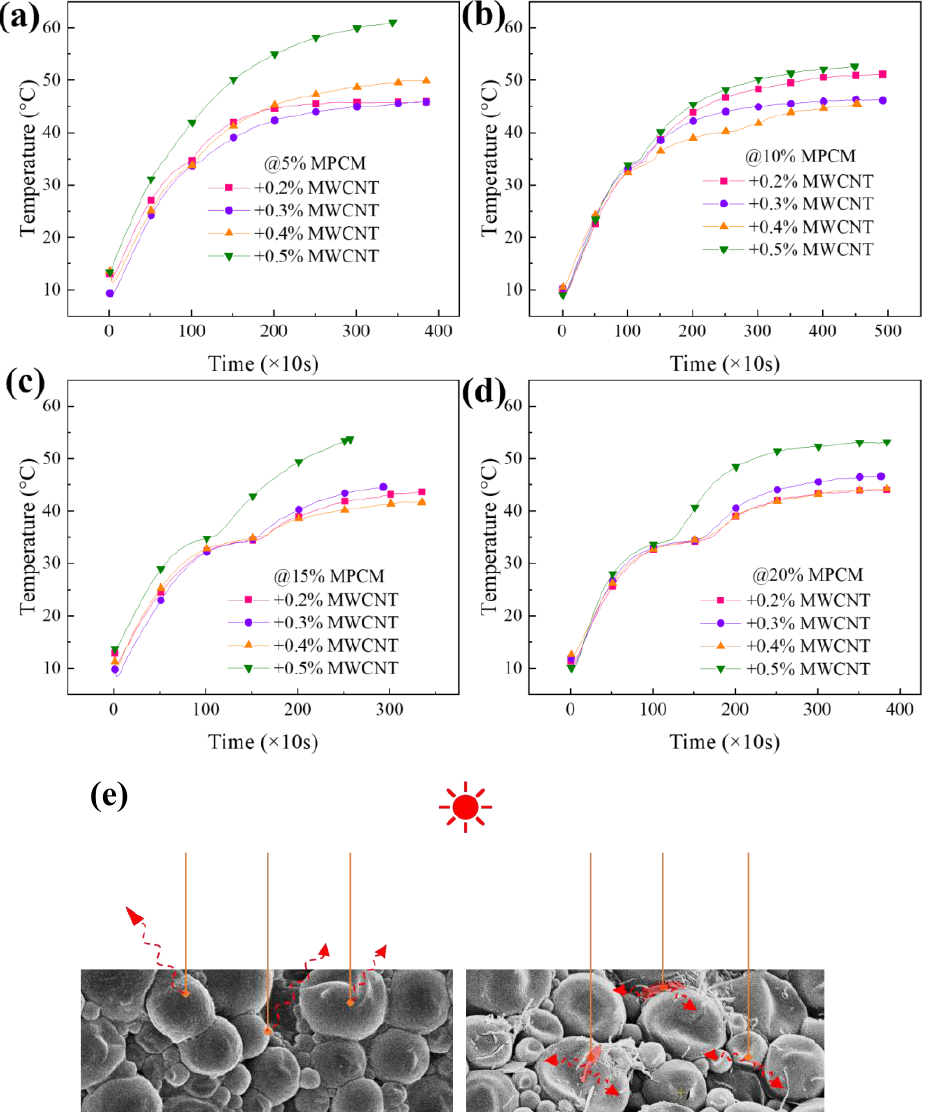
Figure 9. Photothermal performance of MPCM slurry with different MWCNTs: ( a ) 5%MPCM, ( b ) 10%MPCM, ( c ) 15% MPCM, and ( d ) 20% MPCM slurry; ( e ) diagram of the photothermal perfor- mance enhancement mechanism.